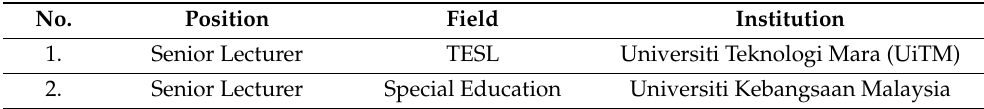
Table 1. List of theme agreement analysis